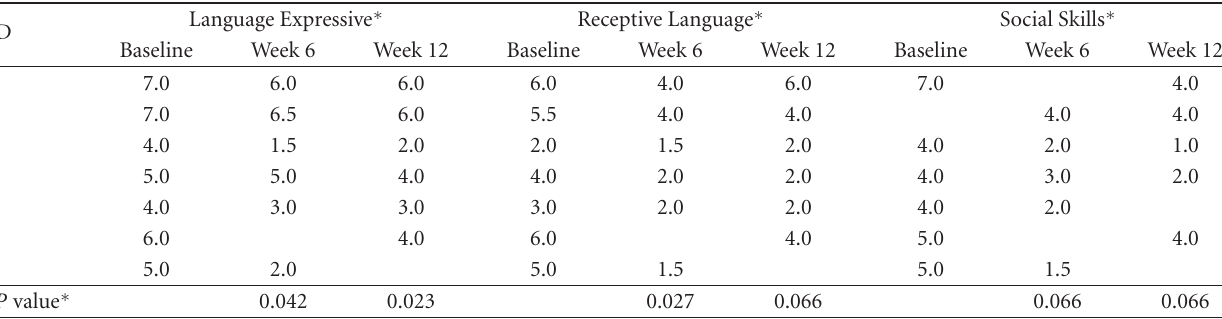
Table 4: Individual clinical global impression ratings over the 12-week study